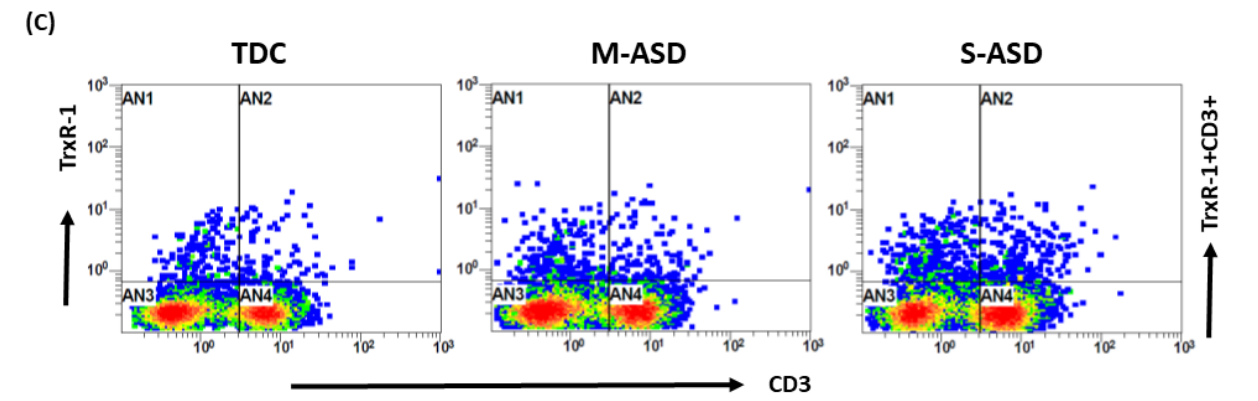
Figure 1. TrxR expression/activity in the T cells of the ASD and TDC groups. ( A ), TrxR1+CD3+T cells, ( B ) TrxR activity in T cells, ( C ) Flow plot displaying the double-positive immunostaining of TrxR1+CD3+T cells. PBMCs and T cells were segregated from whole blood, followed by flow cytometry and enzymatic assay, respectively. The ASD group was further divided into mild–moderate (M-ASD) and severe (S-ASD). Values are shown as the mean ± SEM, n = 22–25/group. ** p < 0.01; *** p < 0.001, **** p < 0.0001.